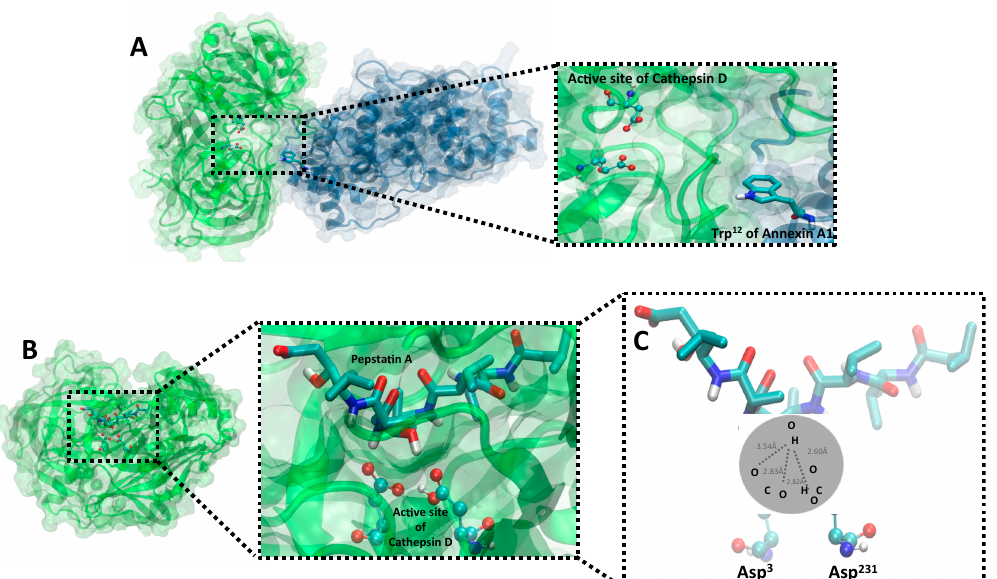
Figure 6. Molecular models of CatD/AnxA1 and CatD/PepA complexes. ( A ) Protein–protein docking of AnxA1 (blue) and CatD (green) interaction highlighting through dashed rectangle, on the zoom view, the active site (ball-and-stick model) of protease nearby AnxA1 Trp 12 (licorice model). ( B ) A protein–ligand docking of CatD and PepA. A zoomed-in image, indicated by dashed lines, focusing on active site of CatD (ball-and-stick model) blocked by PepA (licorice model) is shown. All proteins are represented in cartoon model, whose spirals are alpha-helices and strips with arrows show beta-sheets, and transparent surface indicates the interface region. ( C ) A zoomed-in image at a different angle for better demonstration evidencing binding interactions in the PepA and CatD structure. OH of PepA has a hydrogen bond interaction with carboxylic acid of Asp 33 and Asp 231 (active site of CatD) with contact approximated distances of 3.54 Å, 2.83 Å, 2.832 Å, and 2.60 Å. Ball-and-stick and licorice models are colored by atom (nitrogen, dark blue; oxygen, red; hydrogen, white; carbon, light blue).